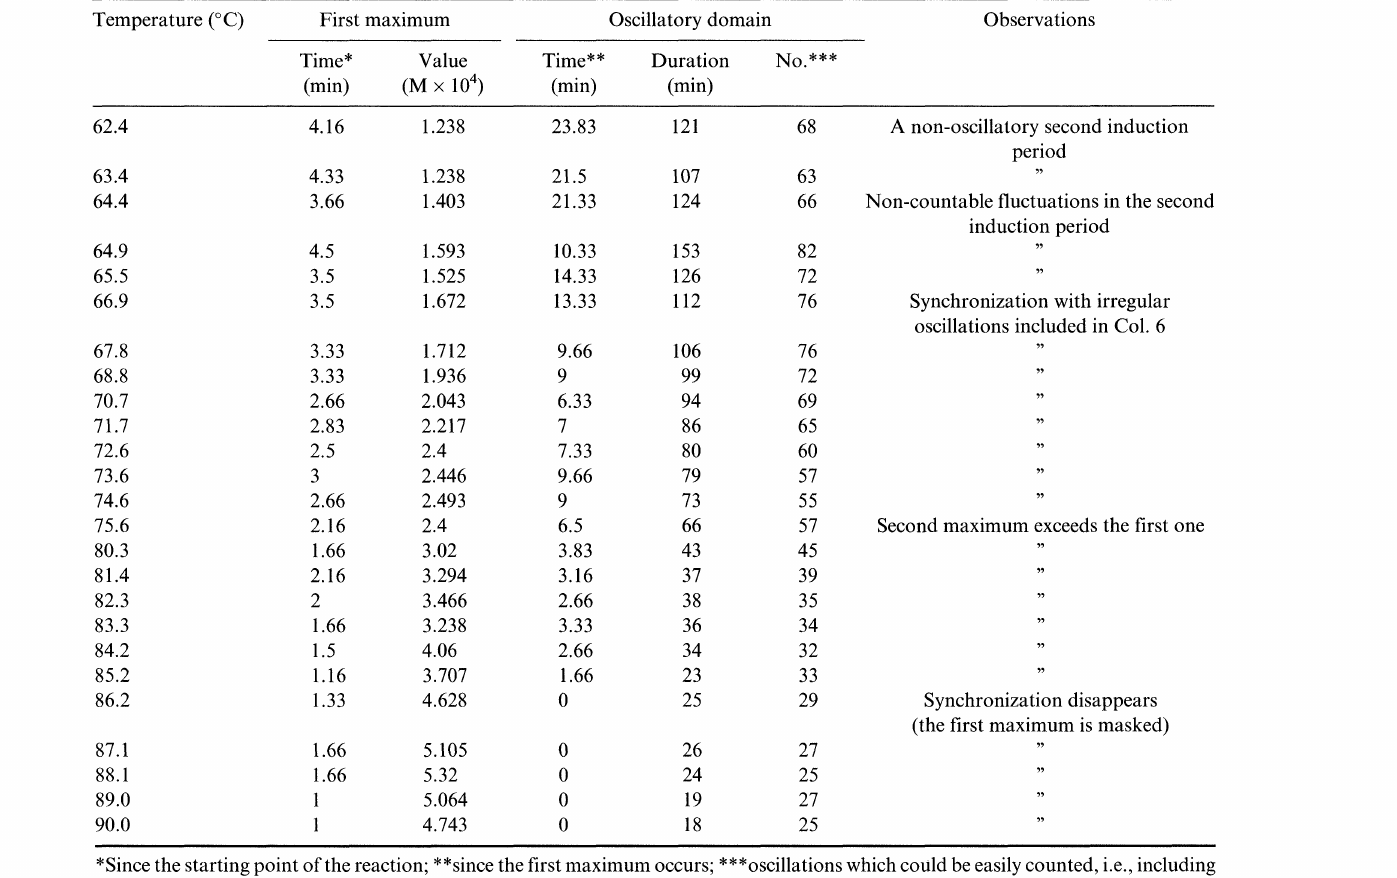
Oscillations of iodine concentration over a wide range of temperatures Temperature (C) First maximum Oscillatory domain